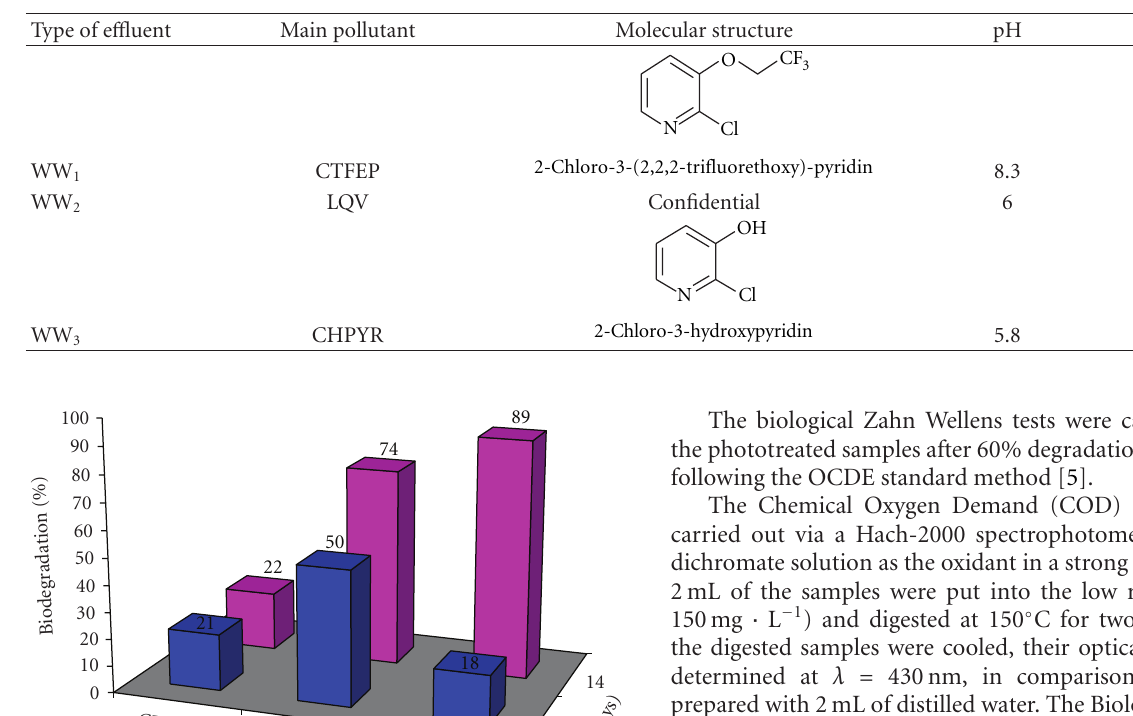
Table 2: Synthesis of the characteristics of the three e ffl uents.